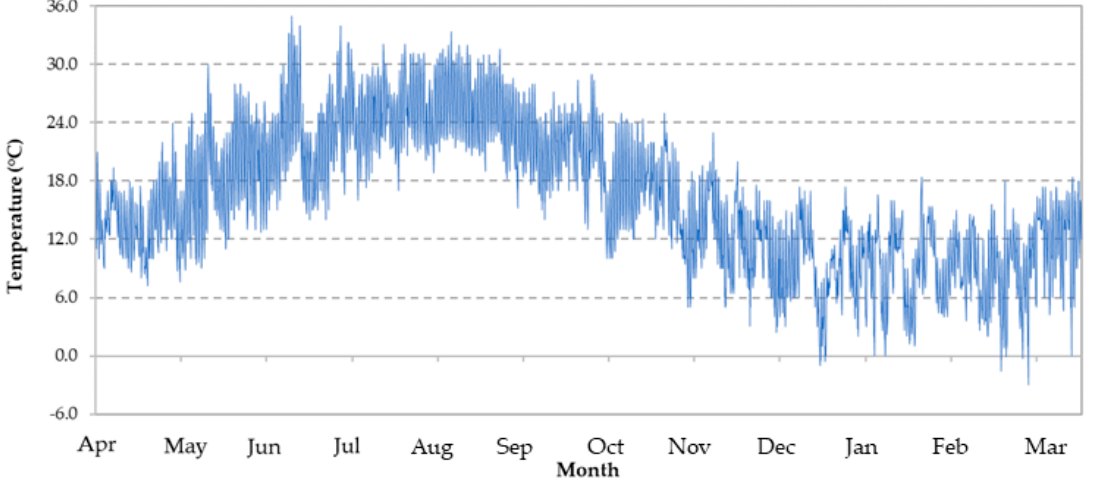
Figure 1. Annual air temperature trend for Naples.